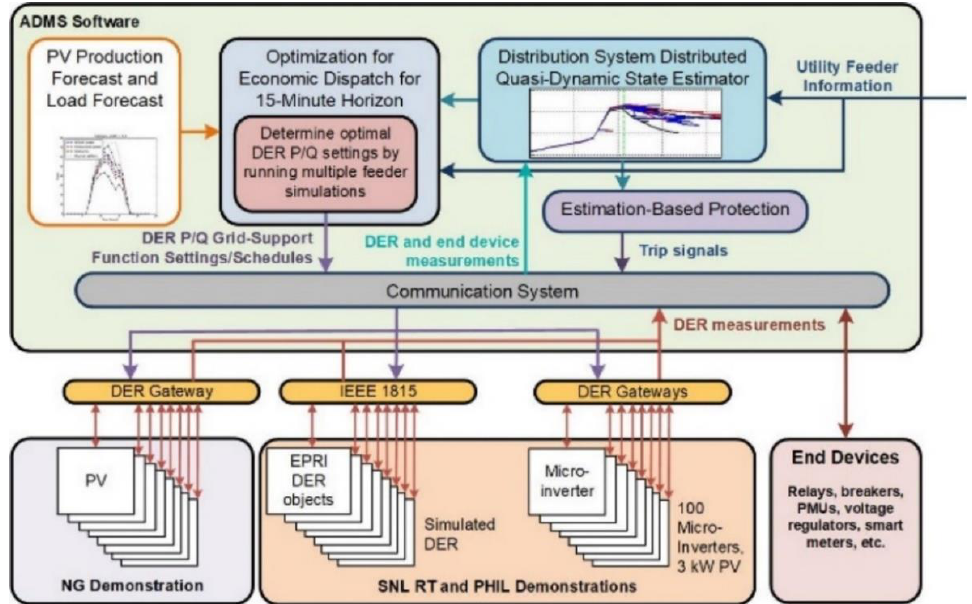
Figure 1. High-level Diagram of each ProDROMOS components and data interfaces.